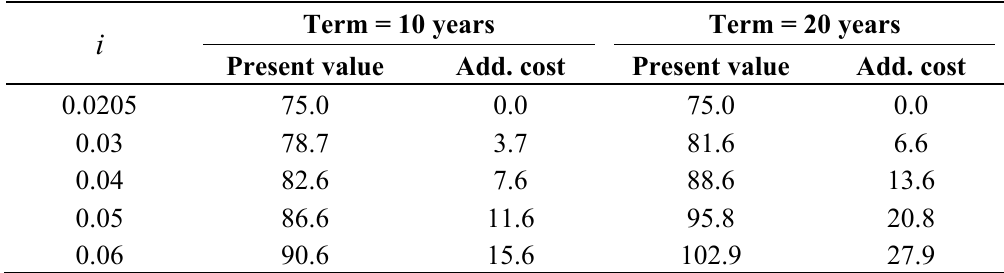
Table 12. Other incentive schemes: Impact on market funding